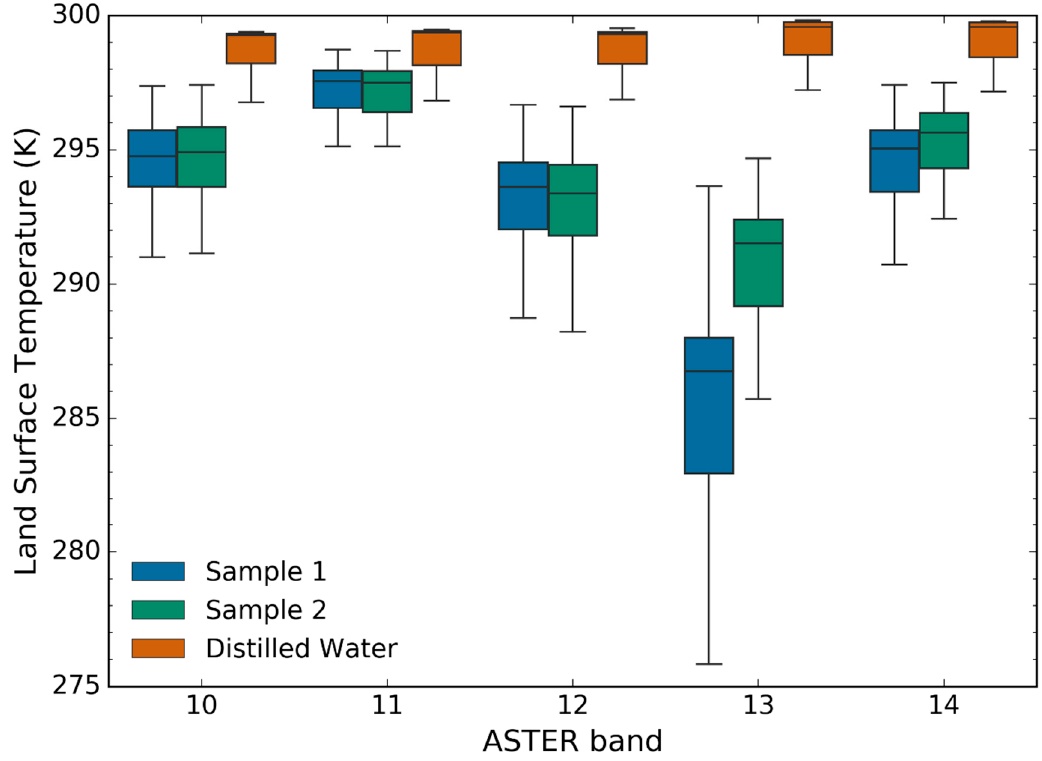
Figure 13. Range of land surface temperatures (K) retrieved from simulated brightness temperature data calculated assuming a typical mid-latitude summer scene with a surface brightness temperature of 300 K, a sky temperature of 260 K and the measured emissivities for each of the three reference samples convolved to ASTER TIR bands 10–14.